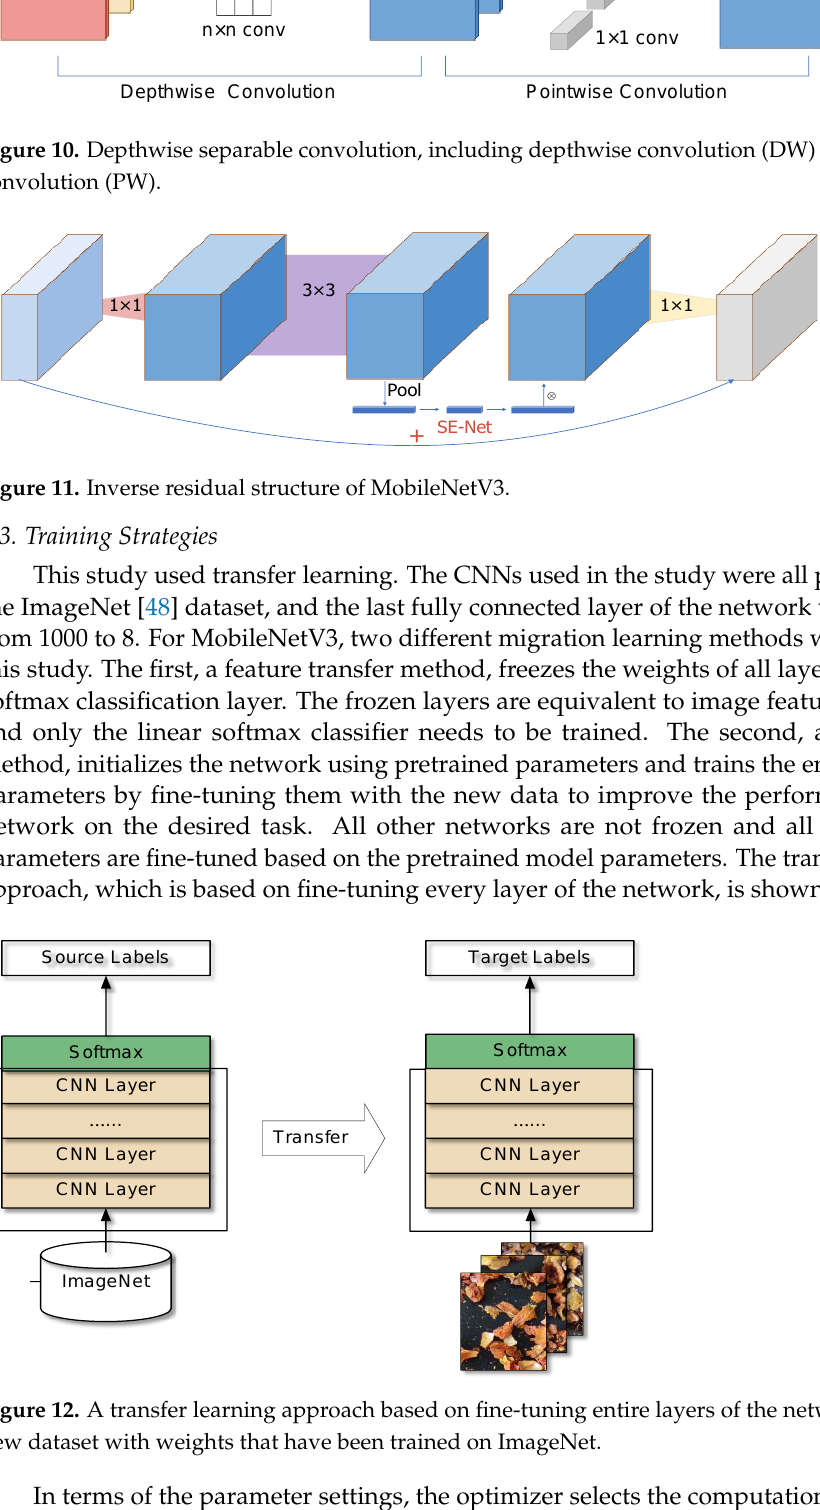
Figure 10. Depthwise separable convolution, including depthwise convolution (DW) and pointwise convolution (PW).